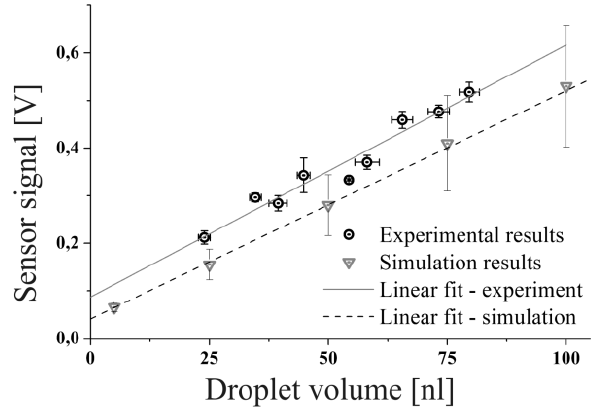
Figure 11. Comparison of the voltage signals obtained from the experiments and the results of the network